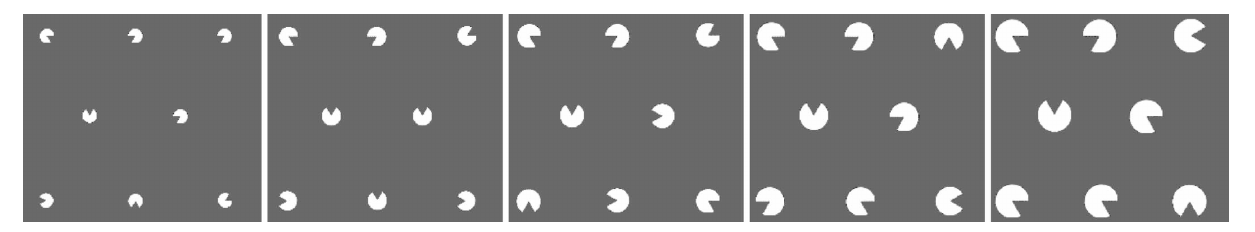
FIGURE 1 | Five 3-2-3 arrays with the five sizes of pacmen, with a Kanizsa triangle in the left upper corner; from left to right: Size